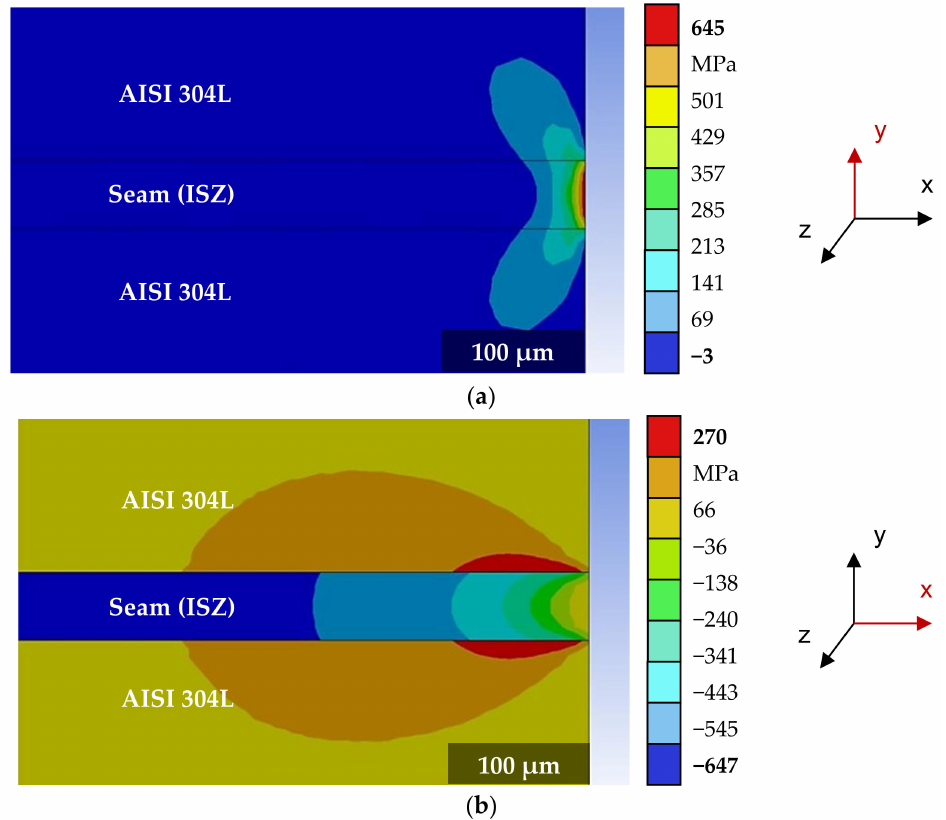
Figure 12. Calculated distribution of the normal residual stresses of ST07 15min after cooling in the ( a ) axial direction (y axis) and ( b ) radial direction (x